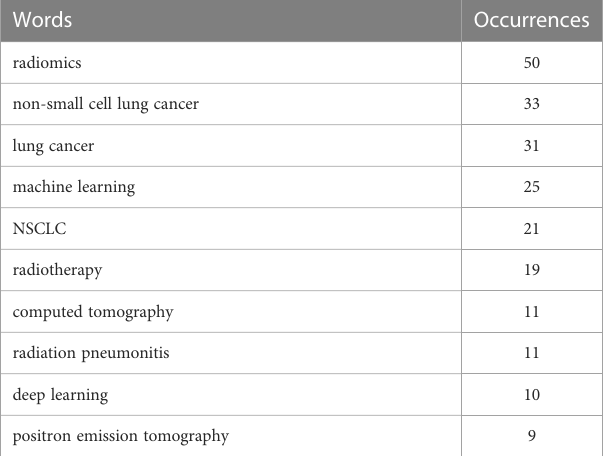
TABLE 1 The top 10 most frequent keywords in bibliometric analysis.